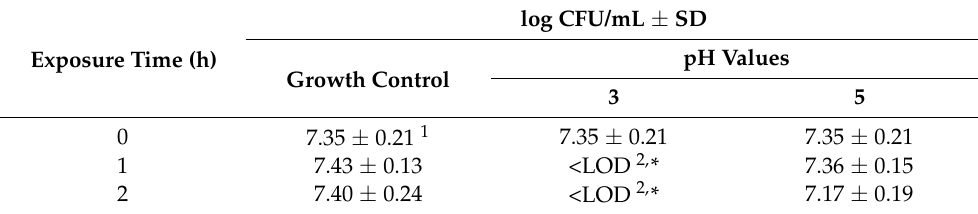
Table 2. Viability of F. duncaniae DSM 17677 free cells when exposed to acidic pH. Data represent the mean values of log CFU/mL ± standard deviation (SD) obtained in growth control and after exposure to pH 3 and pH 5 for 1 and 2